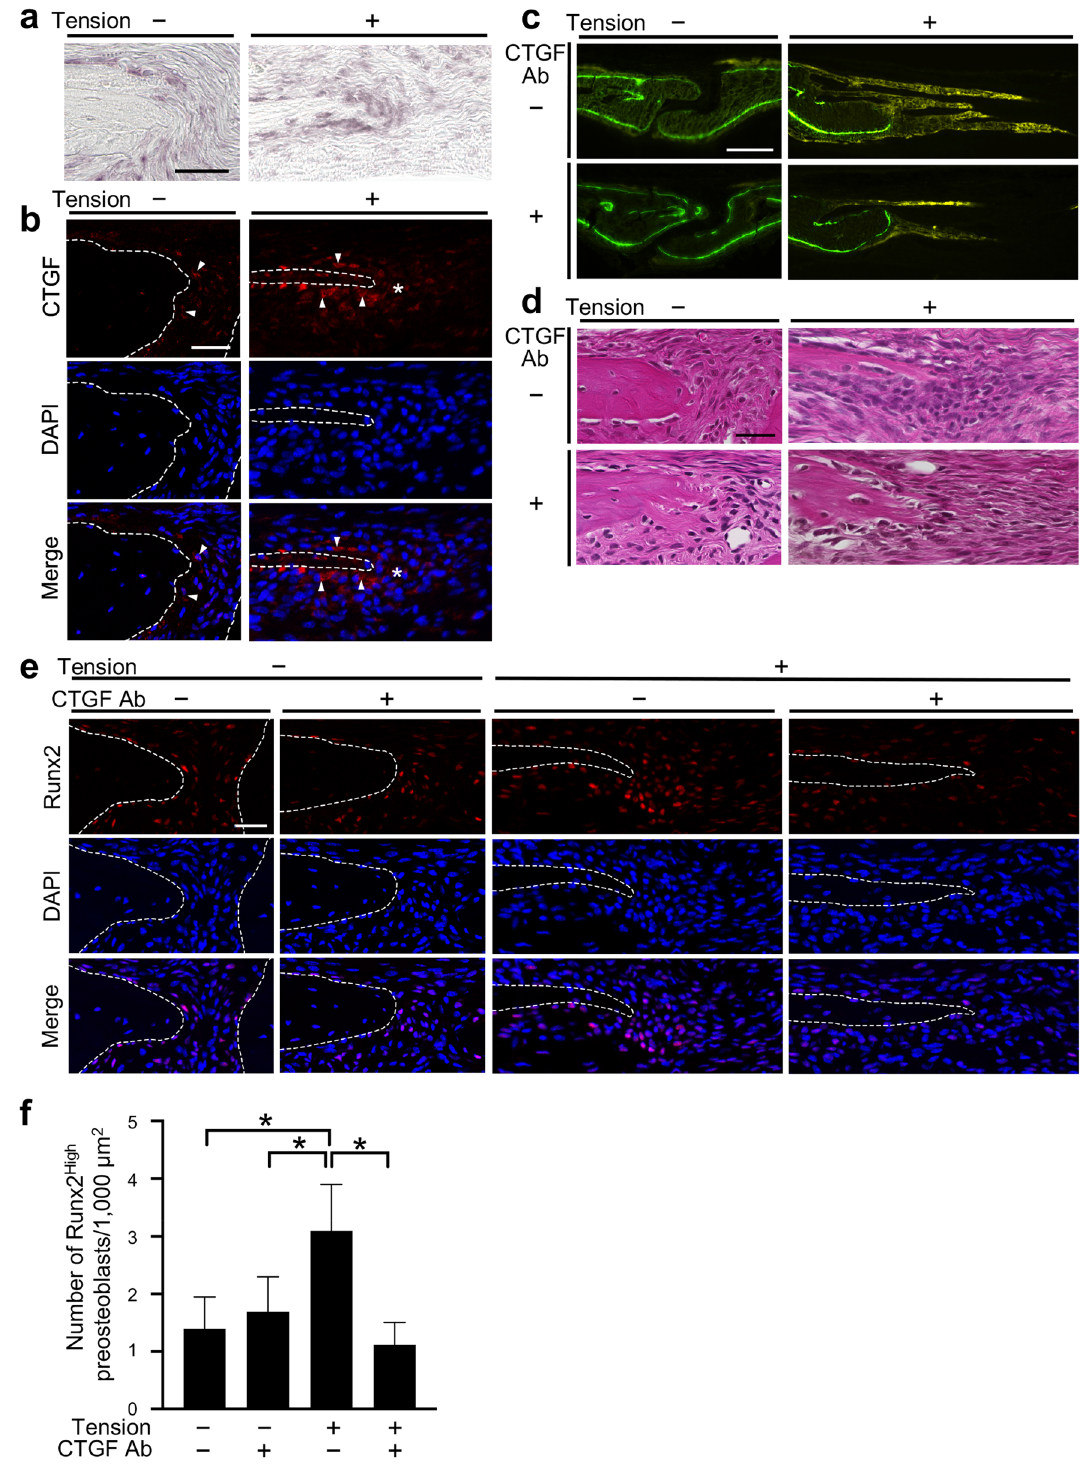
Figure 2. Neutralizing CTGF antibody inhibited the aggregation of preosteoblasts at the osteogenic front in the mouse tensile force-induced bone formation model. ( a , b ) Expression of CTGF at the osteogenic front at 7 days after application of tensile force was analyzed by in situ hybridization ( a ) and immunohistochemistry ( b ). The dotted line in the image of immunohistochemistry indicates the border of mineralized bone. Arrowheads indicate CTGF-positive osteoblasts. Asterisks indicate CTGF expression at the osteogenic front. Scale bar = 30 µm. ( c ) Fluorescence micrographs show bone labels with tetracycline (yellow) and calcein (green) at the edges of the parietal bones. A 100 μl volume of 10 μg/ml neutralizing CTGF antibody was injected subcutaneously into the parietal bone area every day during the experimental period. Scale bar 150 μm. ( d ) The parietal bone and sagittal suture at 7 days after application of tensile force without and with the neutralizing CTGF antibody were stained with hematoxylin and eosin. Scale bar 30 μm. ( e , f ) The expression of Runx2 was analyzed by immunohistochemistry ( e ), and the number of Runx2 High preosteoblasts at the osteogenic front ( f ) was evaluated (6 animals per group). CTGF Ab = neutralizing CTGF antibody. Scale bar = 30 μm. *p < 0.05, ANOVA with Tukey– Kramer post hoc